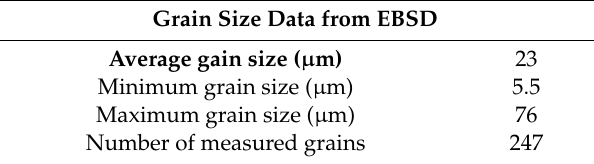
Table 2. EBDS grain-size data.